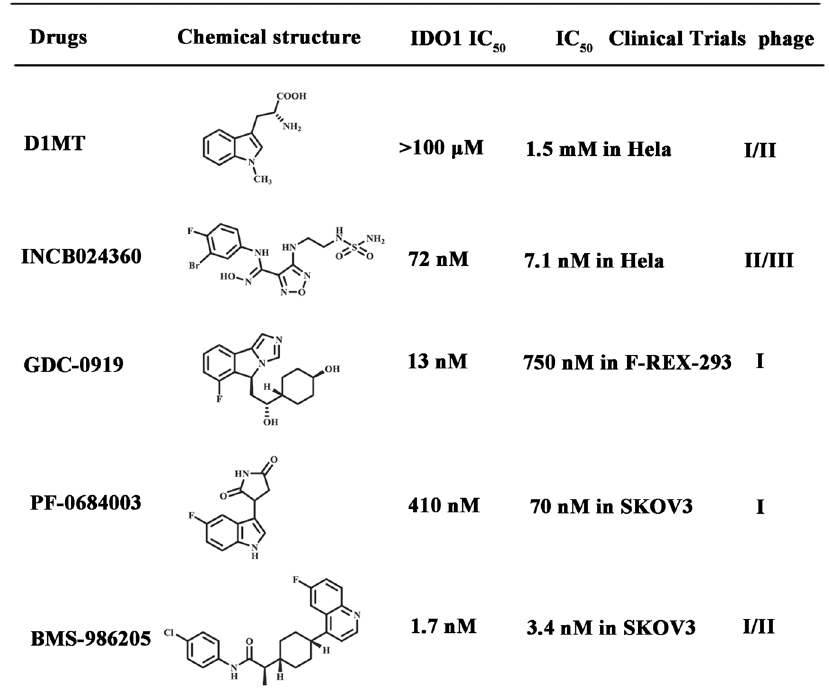
ongoing clinical